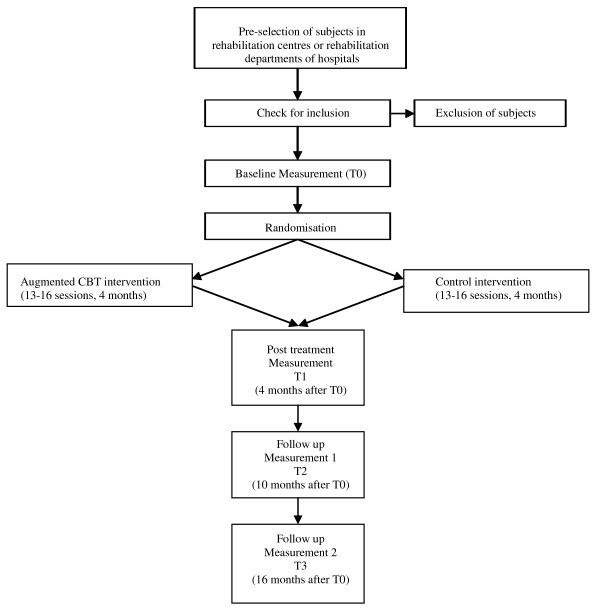
Flow chart of trial design.